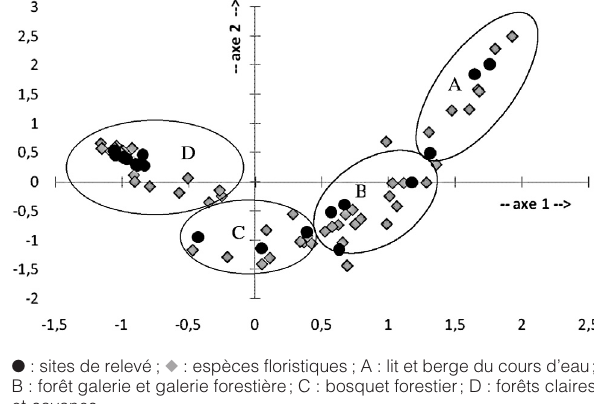
Fig. 2. – Analyse factorielle des correspondances de tous les sites de relevé, plan des axes 1 et